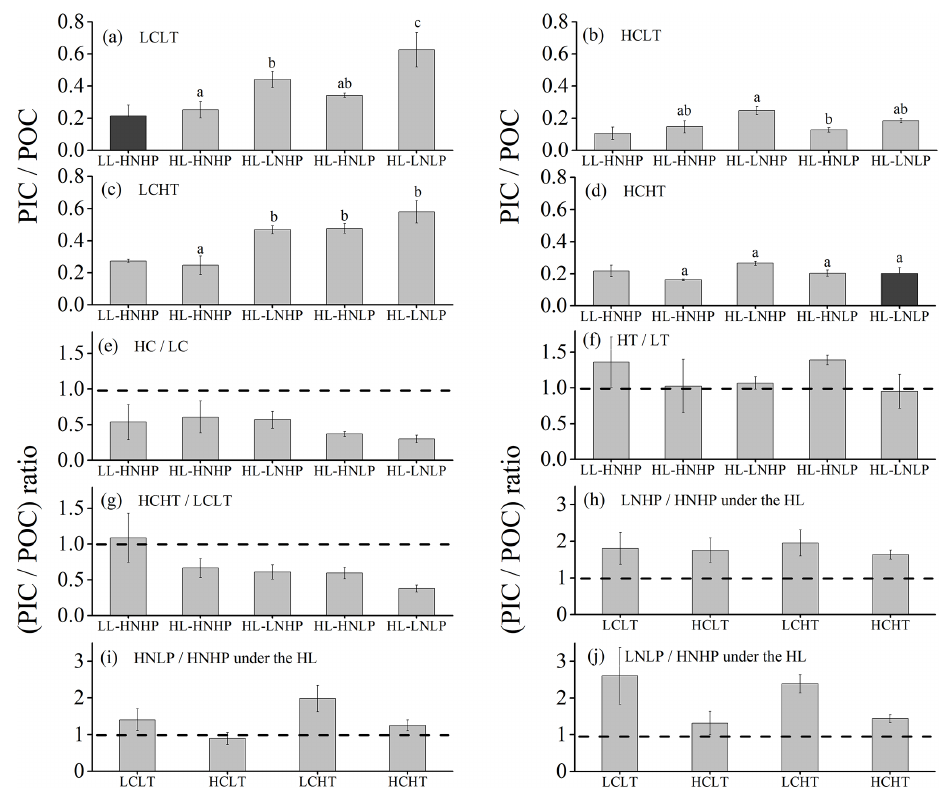
Figure 6. PIC / POC value of E. huxleyi grown in LCLT (a) , HCLT (b) , LCHT (c) and HCHT (d) conditions and the ratio of (PIC / POC value) in HC to LC (e) , HT to LT (f) , HCHT to LCLT (g) , LNHP to HNHP (h) , HNLP to HNHP (i) and LNLP to HNHP (j) conditions. Data were obtained after cells were acclimated to experimental conditions for 14–16 generations and means ± SD of four replicate populations. Horizontal lines in (e) – (j) show the value of 1. Different letters (a, b, c) in (a) – (d) represent significant differences between different nutrient treatments (Tukey post hoc, p < 0.05). The results shown in the black columns were used for the ambient-future comparison in Fig. 2. Detailed experimental conditions are shown in Fig.